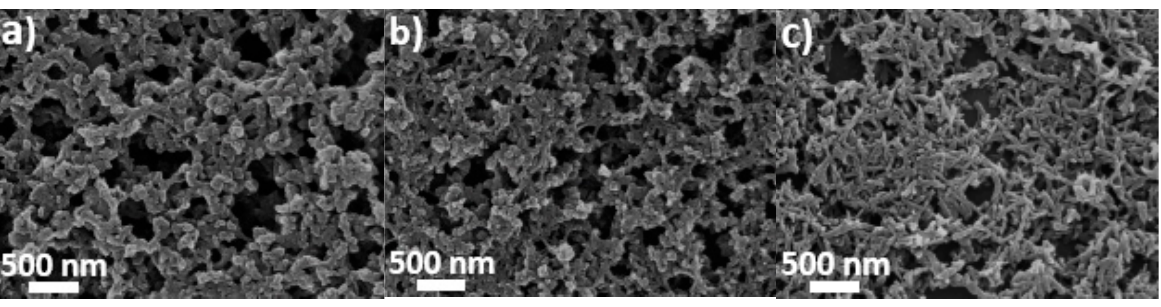
Figure 3. Morphologies of PANI materials obtained when the CTAB was replaced by ( a ) sodium dodecyl benzene sulfonate (SDBS), ( b ) Triton X-100 or, ( c ) Span 40. The other conditions are the same as that for Figure